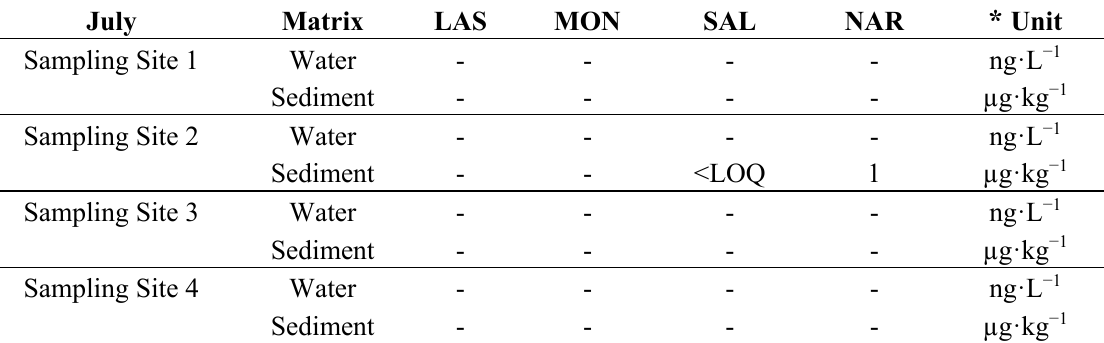
Table 1. Results of July 2011 sampling campaign at Sites 1–4.